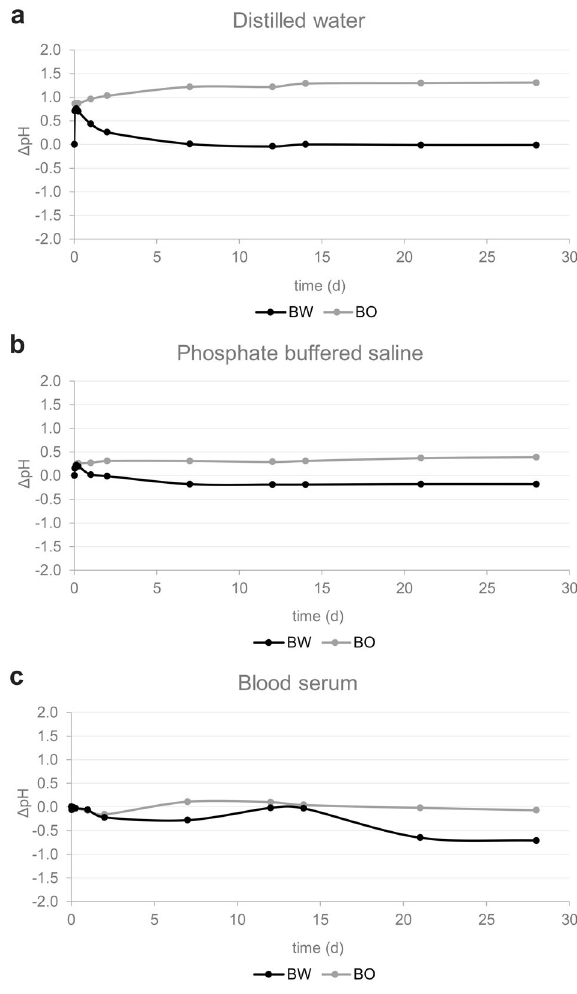
Fig. 5 Δ pH of bone graft material BW and BO stored in a distilled water, b phosphate buffered saline and c blood serum for the respec- tive time intervals